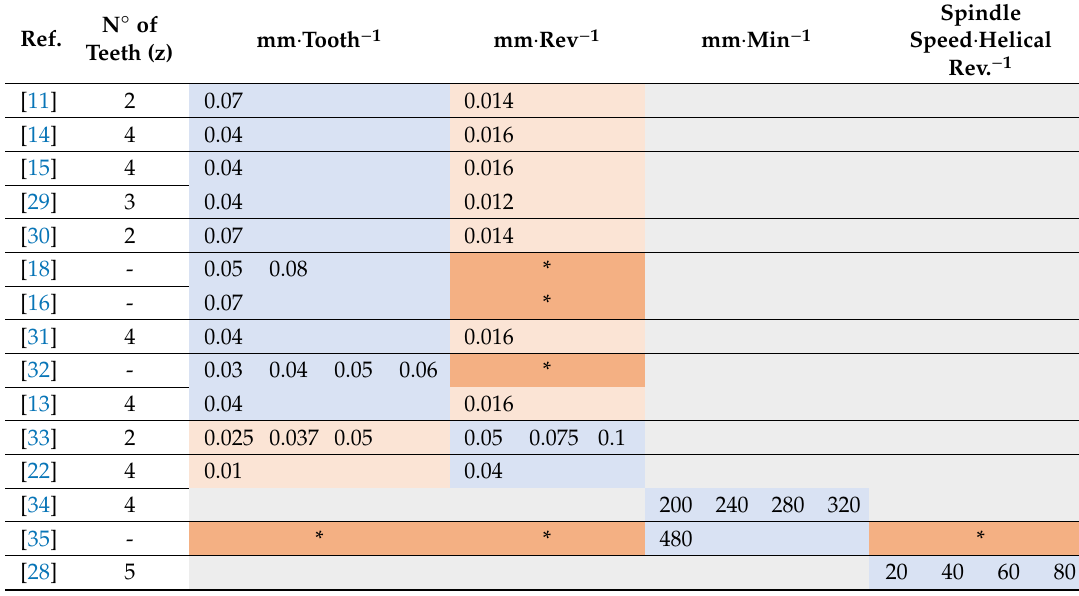
Table 2. Values provided in the publication consulted for tangential